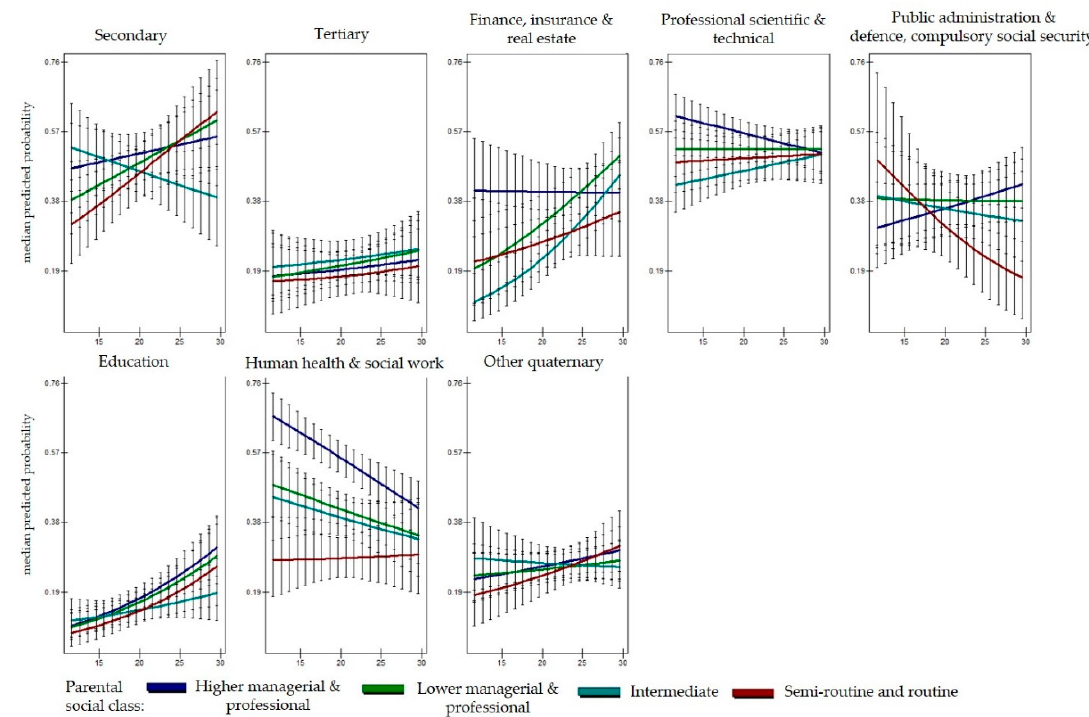
Figure 5. Graduates’ probability of attaining a top-level job by social class of origin, by percentages of professional jobs in the employment area (NUTS 3) and by type of industry. Predicted median probability from a three-way interaction model. Note: Primary industry suppressed due to small sample size.